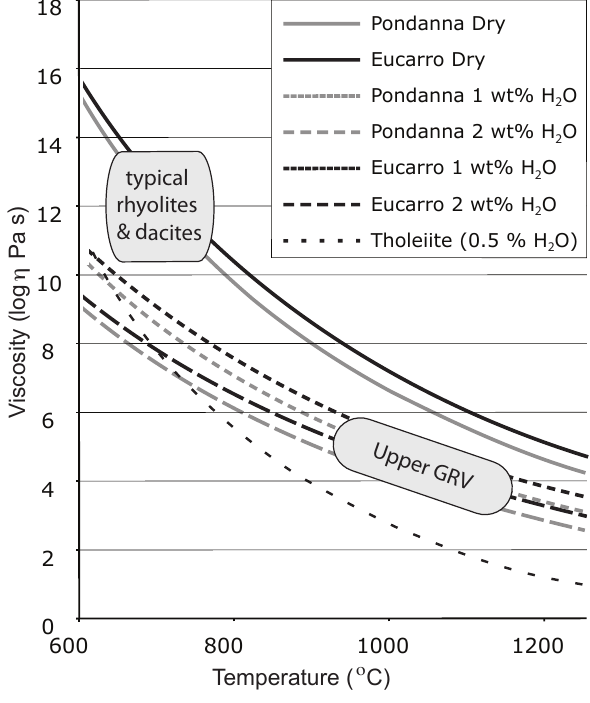
Fig. 4. Viscosity vs. Temperature plot illustrating calculated palaeo- viscosities of Pondanna Dacite and the Eucarro Rhyolite using mea- sured fluorine and 0.02, 1 and 2wt% H 2 O contents for these units. A typical theoretical tholeiitic basalt composition (see Table 2) has also been modeled for comparison. The results indicate that a combination of unusually high magmatic temperatures and elevated halogen content decrease the viscosity of melts of the composition of the Gawler Range Volcanics towards typical values of